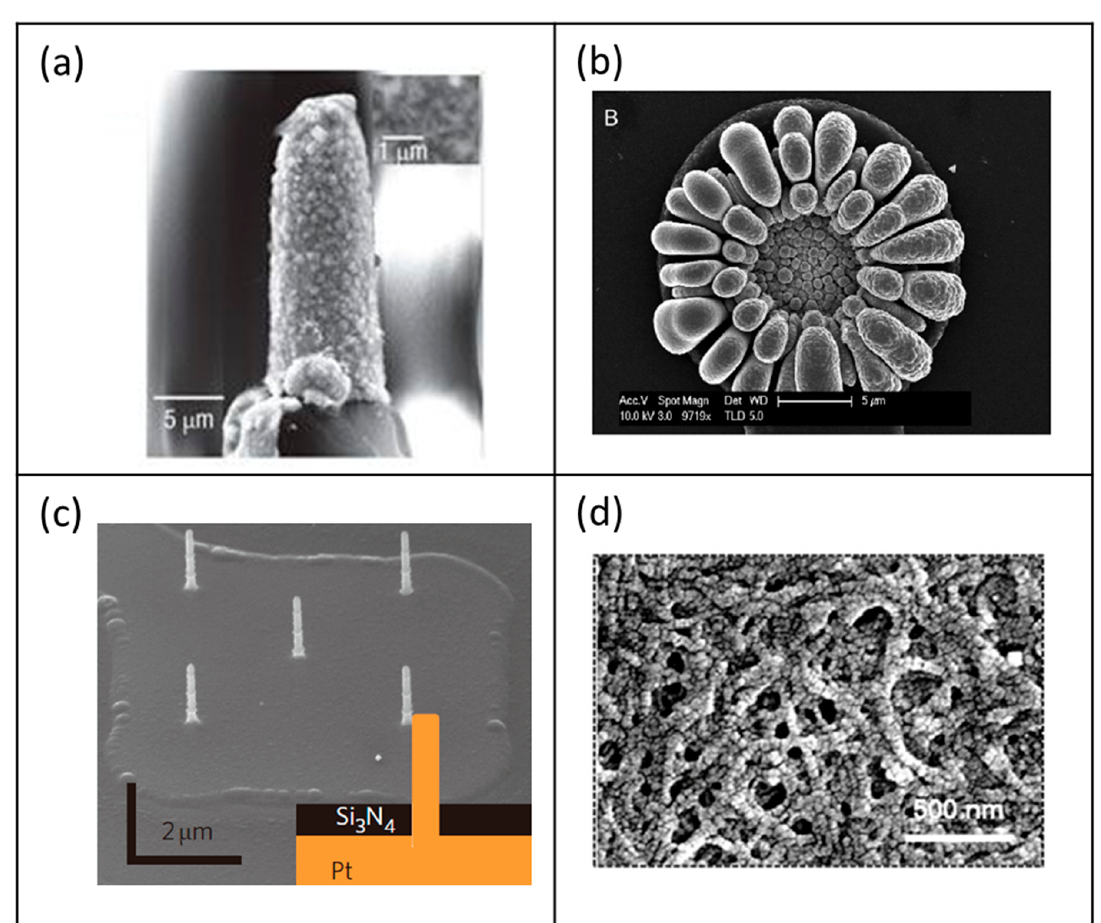
Figure 9. Various surface modification techniques for improved neural signal recording performance.